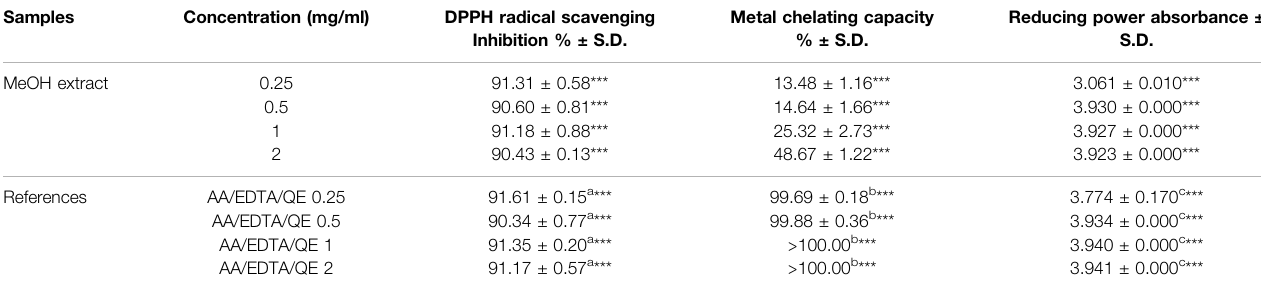
TABLE 1 | Results of DPPH radical scavenging activity, metal chelating capacity and reducing power absorbance of P. atlantica MeOH extract. Samples